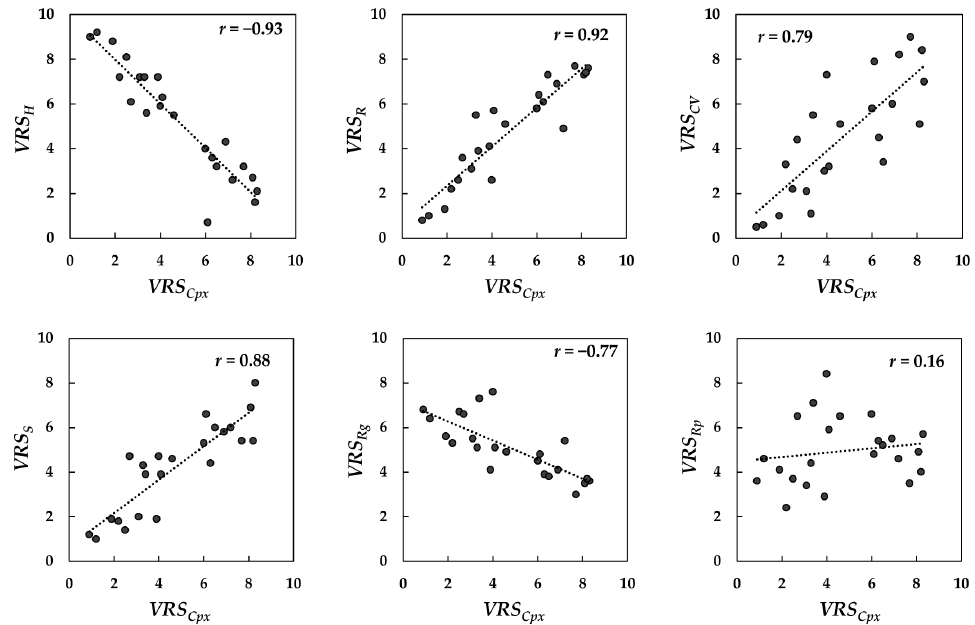
Figure 7. The correlation between the VRS of complexity ( VRS Cpx ) and the VRS of homogeneity ( VRS H ), randomness ( VRS R ), color variation ( VRS CV ), strongness ( VRS S ), regularity ( VRS Rg ), and repetitiveness ( VRS Rp ) for the 23 textiles used in this research.